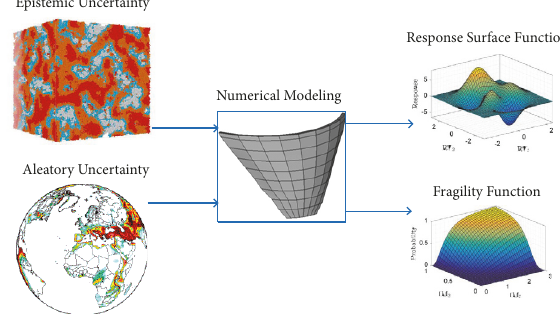
Figure 1: General framework for uncertainty